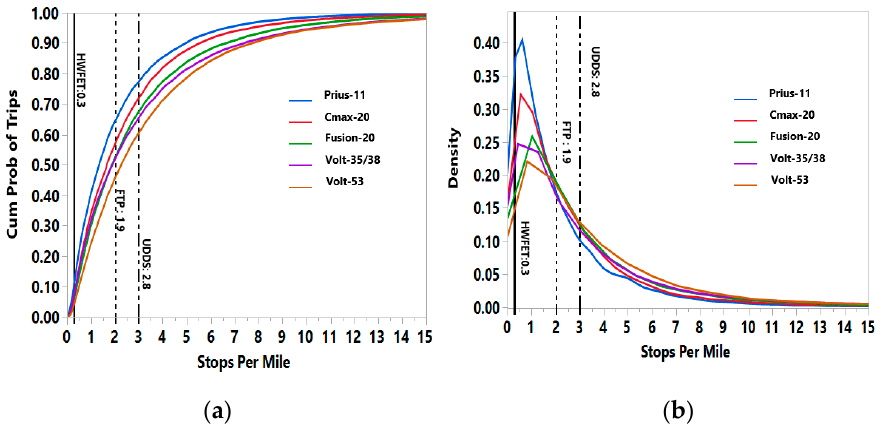
Figure 4. Distribution of stops per mile. ( a ) Cumulative distribution function (CDF); ( b ) Density plot. Vertical lines are drawn to indicate representative highway and urban drive cycles stops per mile.